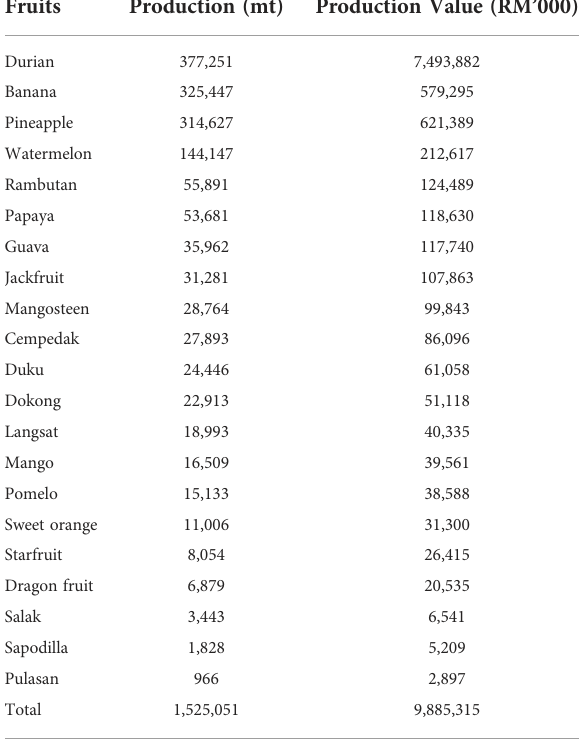
TABLE 1 Production value of major tropical fruits in Malaysia,